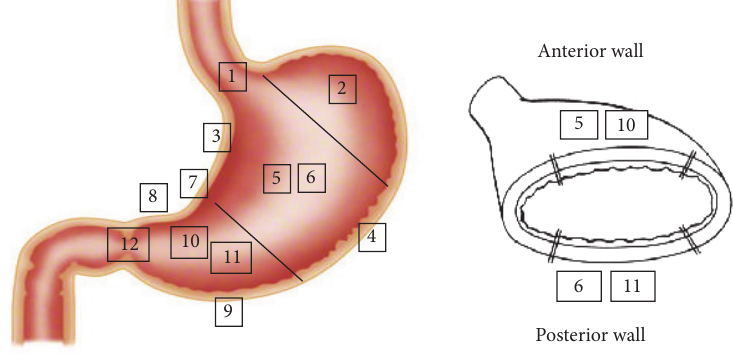
Figure 2: Twelve locations divided according to the consideration of a variable situation. 1: the lesion across the esophagogastric junction (AEGJ); 2: fornix; 3: lesser curvature of the body; 4: greater curvature of the body; 5: anterior wall of the body; 6: posterior wall of the body; 7: lesion across the angle; 8: lesser curvature of the antrum; 9: greater curvature of the antrum; 10: anterior wall of the antrum; 11: posterior wall of the antrum; 12: lesion across a pylorus ring